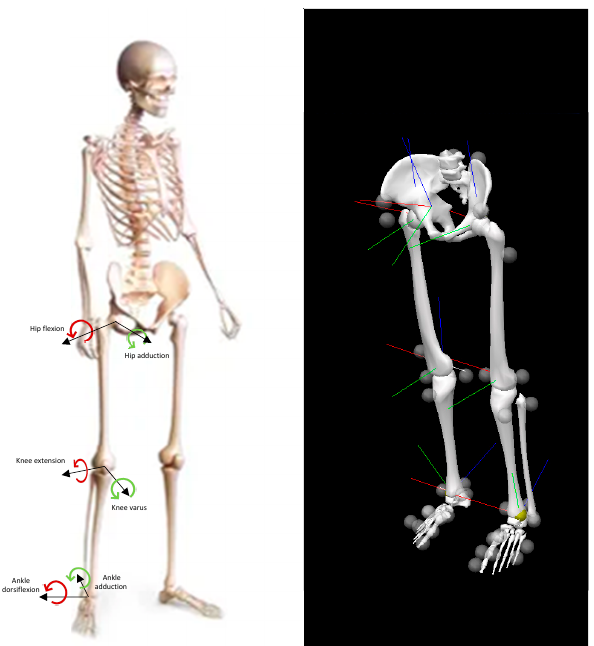
Figure 2. Graphic representation of the nomenclature adopted to describe the lower limb movements and angles and their respective signal in the frontal and sagittal